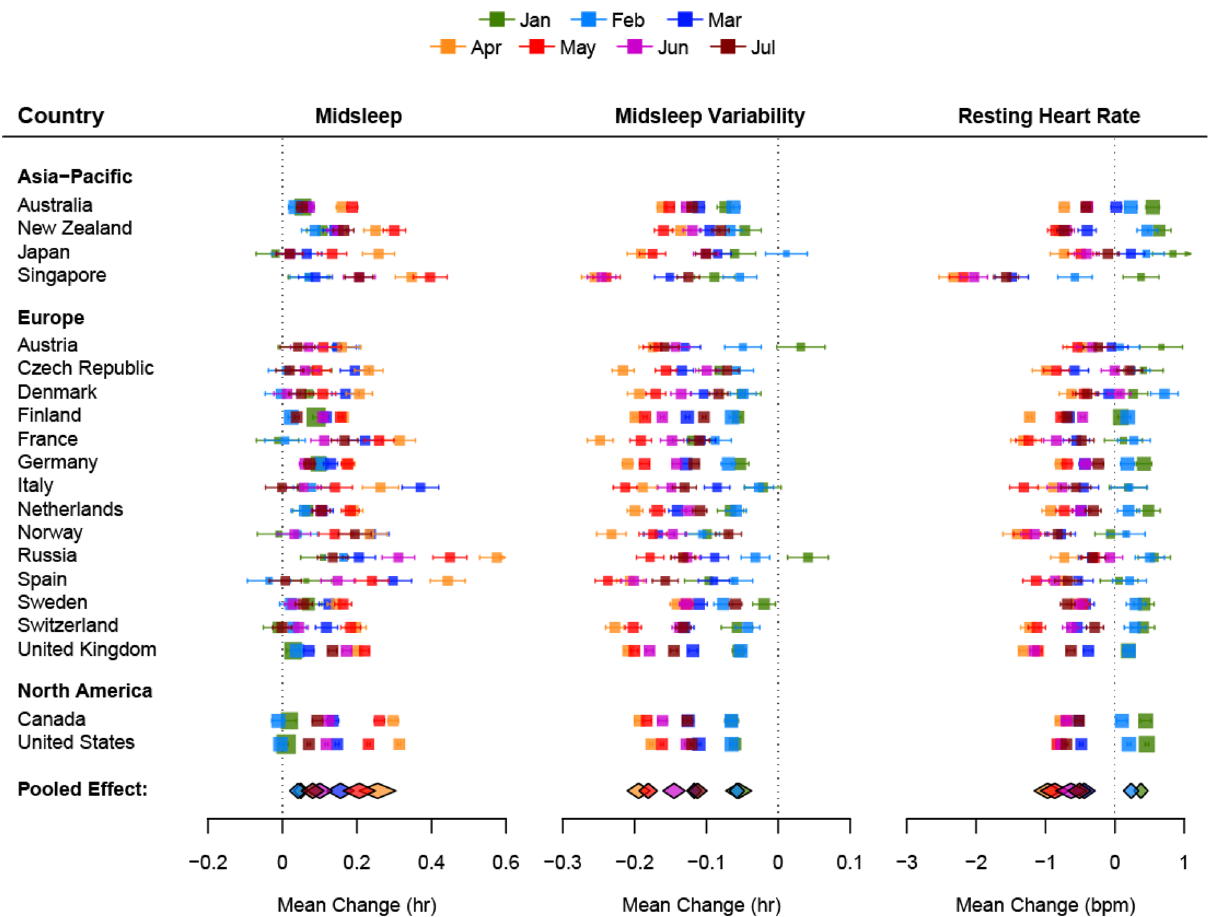
Figure 2. Forest plots of the average change in midsleep time, midsleep variability and resting heart rate by month and country. The size of the colored squares is proportional to the sample size of each country while whiskers indicate the mean and 95% confidence interval of the estimated difference between 2020 and 2019 by month (Jan–Jul). The overall pooled effect across countries for each month is represented by the colored diamonds below each